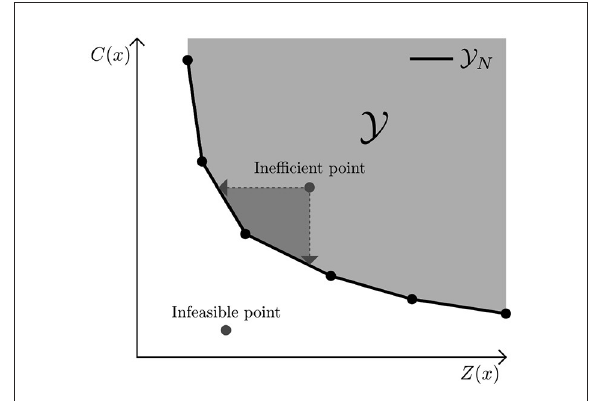
FIGURE1 Example of a Pareto Frontier, where C ( x ) represents the cost of a diet and Z ( x ) the nutritional inadequacy. Y is the criterion space, which represents all feasible combinations of C ( x ) and Z ( x ). Y N only contains nondominated